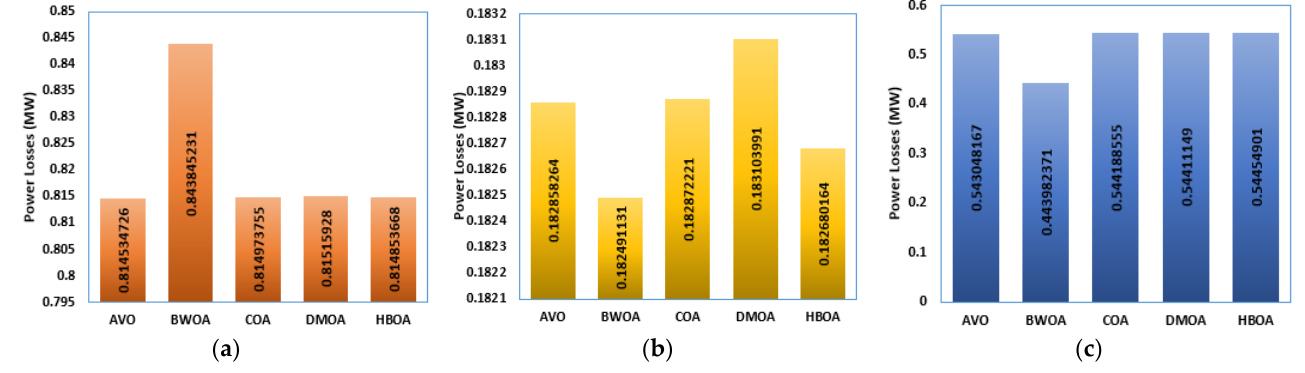
Figure 9. Power losses of Case 2 for the three loading levels. ( a ) First Loading Level; ( b ) Second Loading Level; ( c ) Third Loading Level.